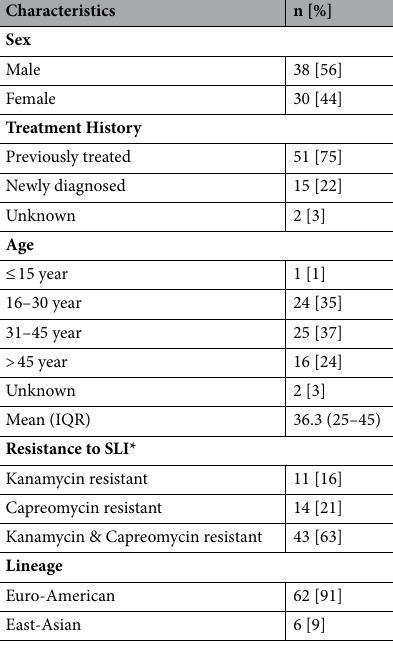
Table 1. Characteristics of patients with XDR-TB. IQR interquartile range, SLI Second-Line Injectable. *Results obtained from Proportion Method in Middlebrook 7H10 agar. All strains had additional phenotypic resistance to rifampicin, isoniazid, and